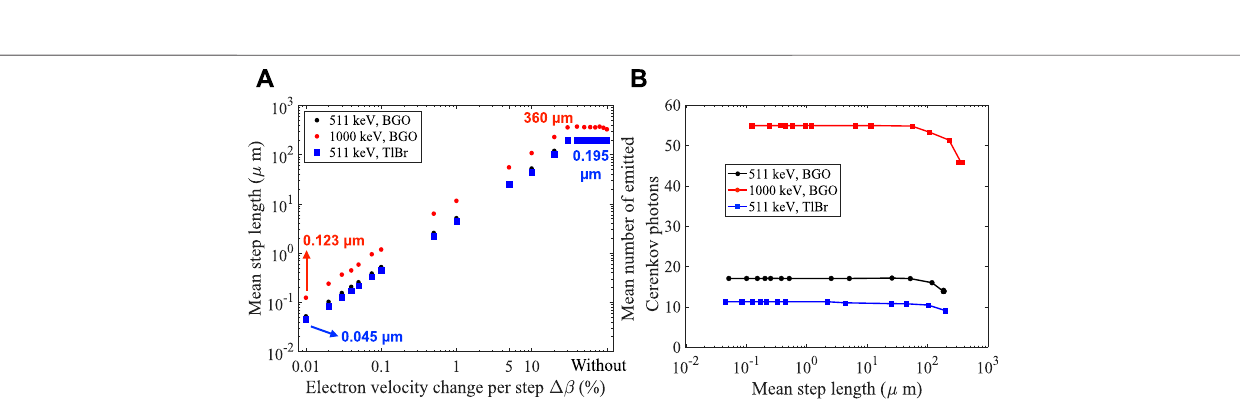
FIGURE 9 | (A) Mean step length as a function of the electron velocity change per step, in logarithmic scale. (B) Mean number of emitted Cerenkov photons for photoelectric interaction as a function of the electron mean step length. Results are shown for BGO in its transmission range (320 – 800 nm), using 511 and 1,000 keV. TlBr was simulated within its transmission range at 511 keV (440 – 800